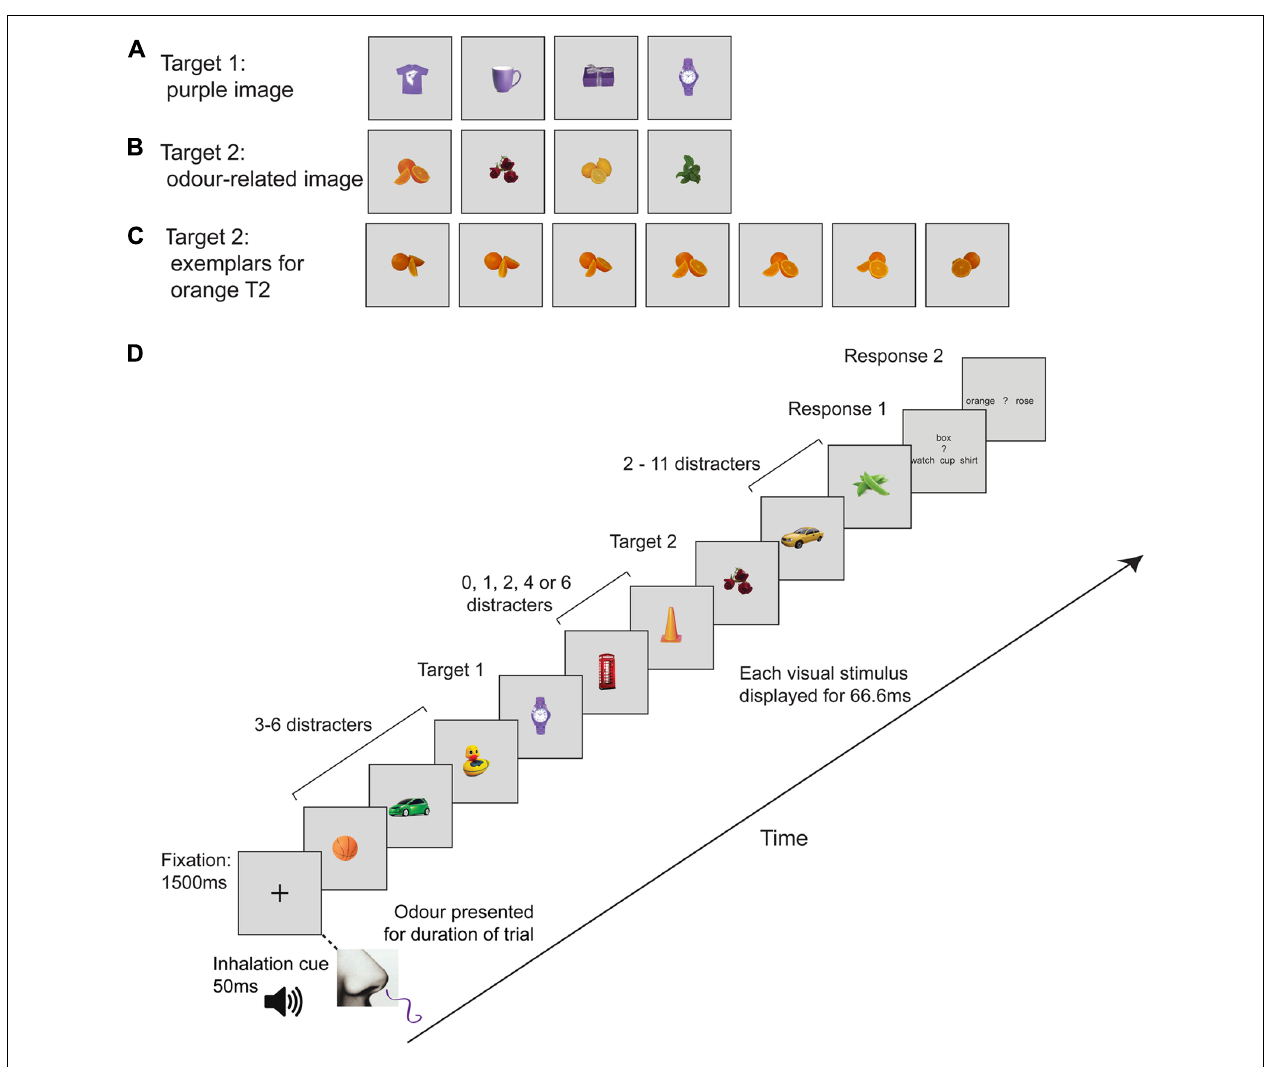
presented for 1500 ms and then 16 images appeared one after another at 67 ms each.T1 andT2 were separated by 0, 1, 2, 4, or 6 images, which corresponds toT1–T2 lags of 1, 2, 3, 5, or 7. An odor presented for the entire duration of each trial was either congruent, incongruent or irrelevant.Trials involving plain air (“no odor”) were randomly intermingled as a means of verifying the presence of an AB in the absence of olfactory